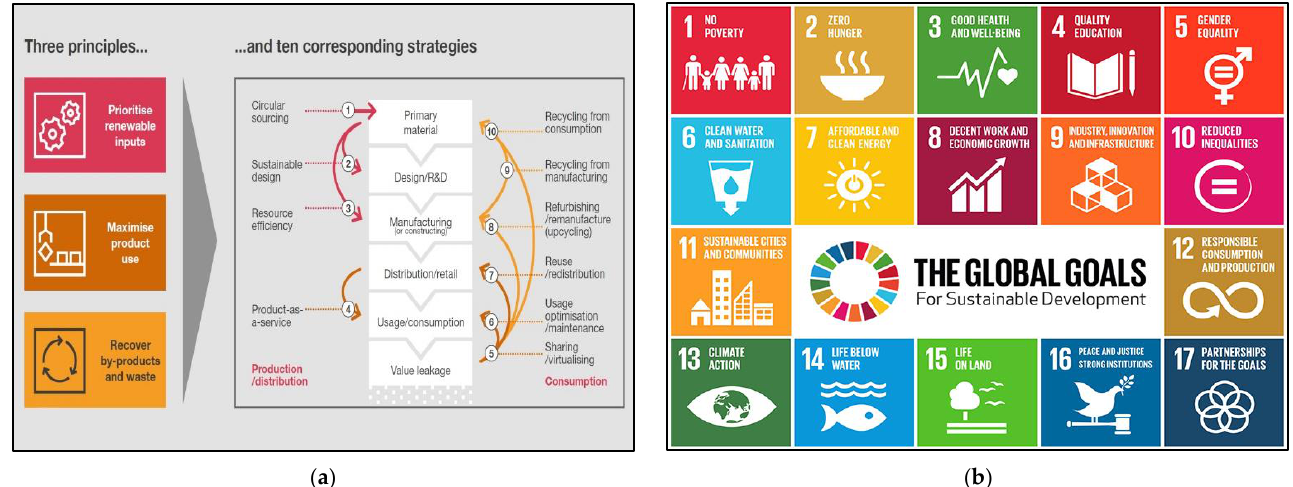
Figure 2. ( a ) Three principles with ten corresponding strategies regarding circular economy [81]. ( b ) SDGs [76] . ( b ) SDGs